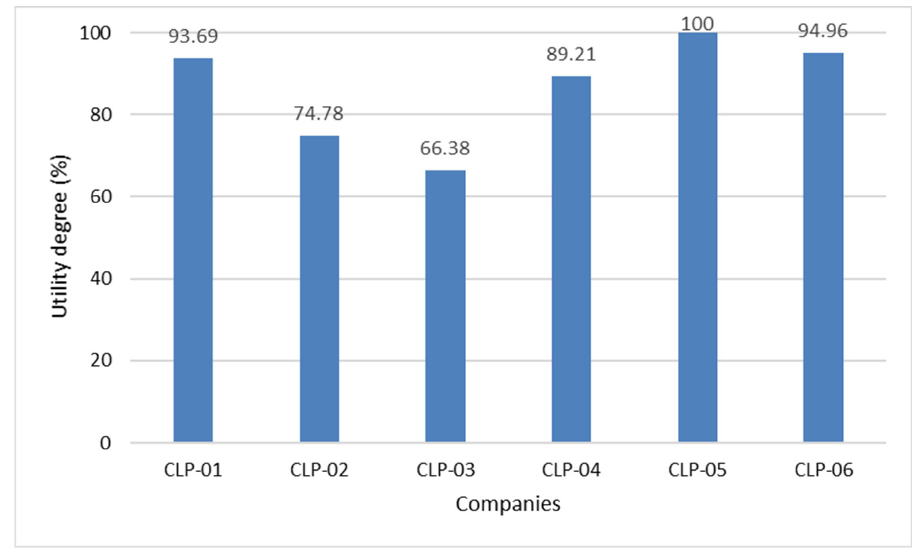
Figure 5. Final alternatives ranking of the G-COPRAS.